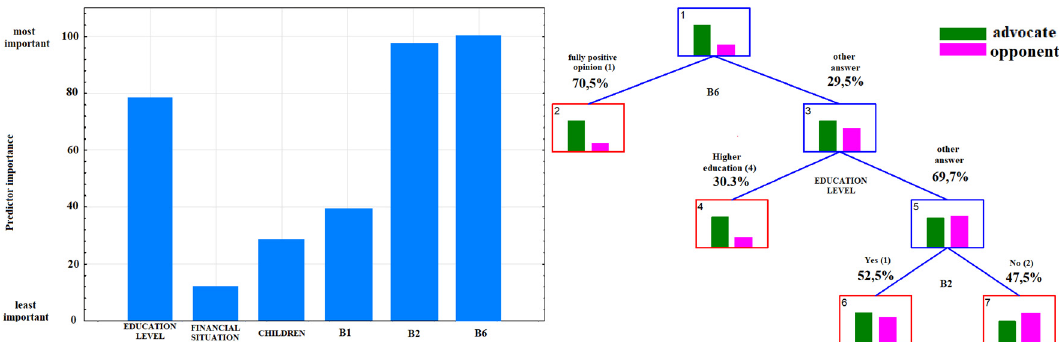
Figure 7. Ranking of predictors and decision tree for answer to the question B8: “Do you consider yourself an advocate or opponent of vaccination?” after excluding question B9.